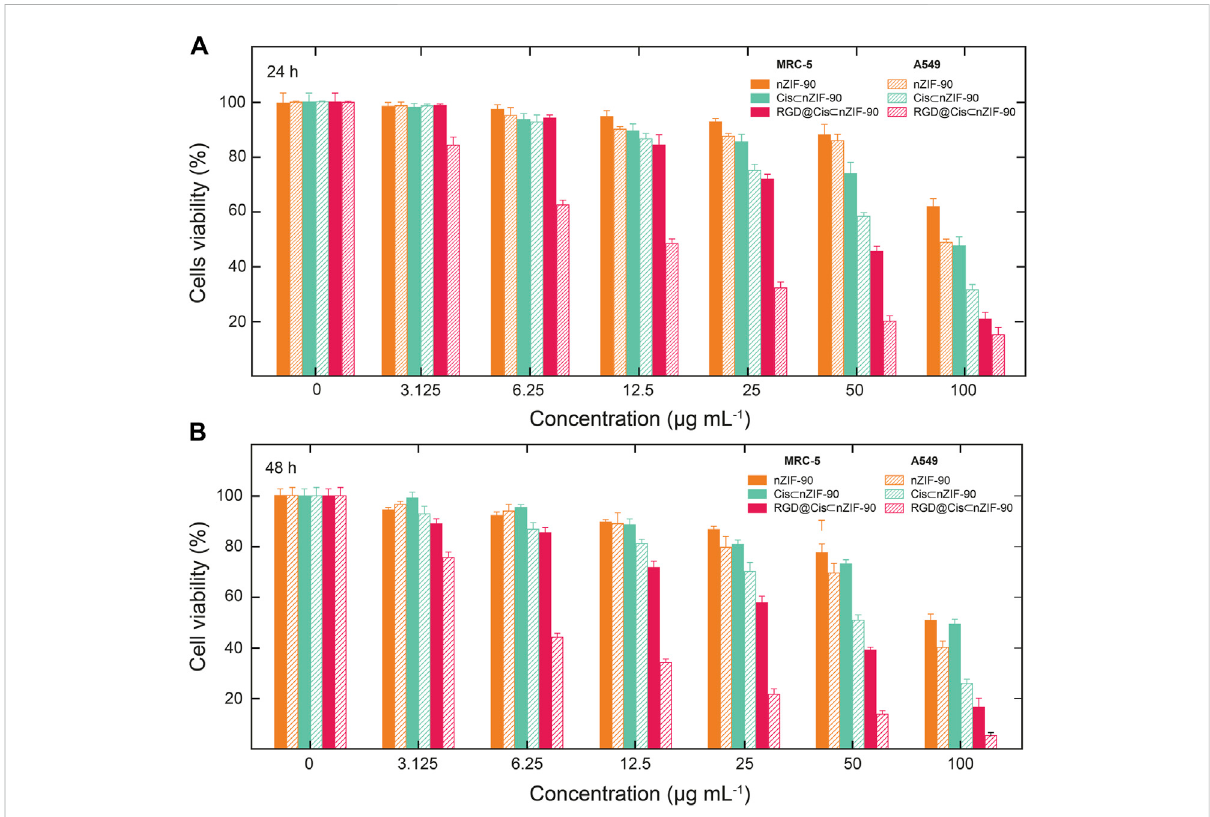
FIGURE 5 Cytotoxicity was assessed by MTT assay following treatment of A549 cells and MRC-5 cells with nZIF-90 (orange), Cis ⊂ nZIF-90 (green) and RGD@Cis ⊂ nZIF-90 (red) for (A) 24 h and (B) 48 h. Percentages of cell viability are presented as a function of nanoparticle concentration used.